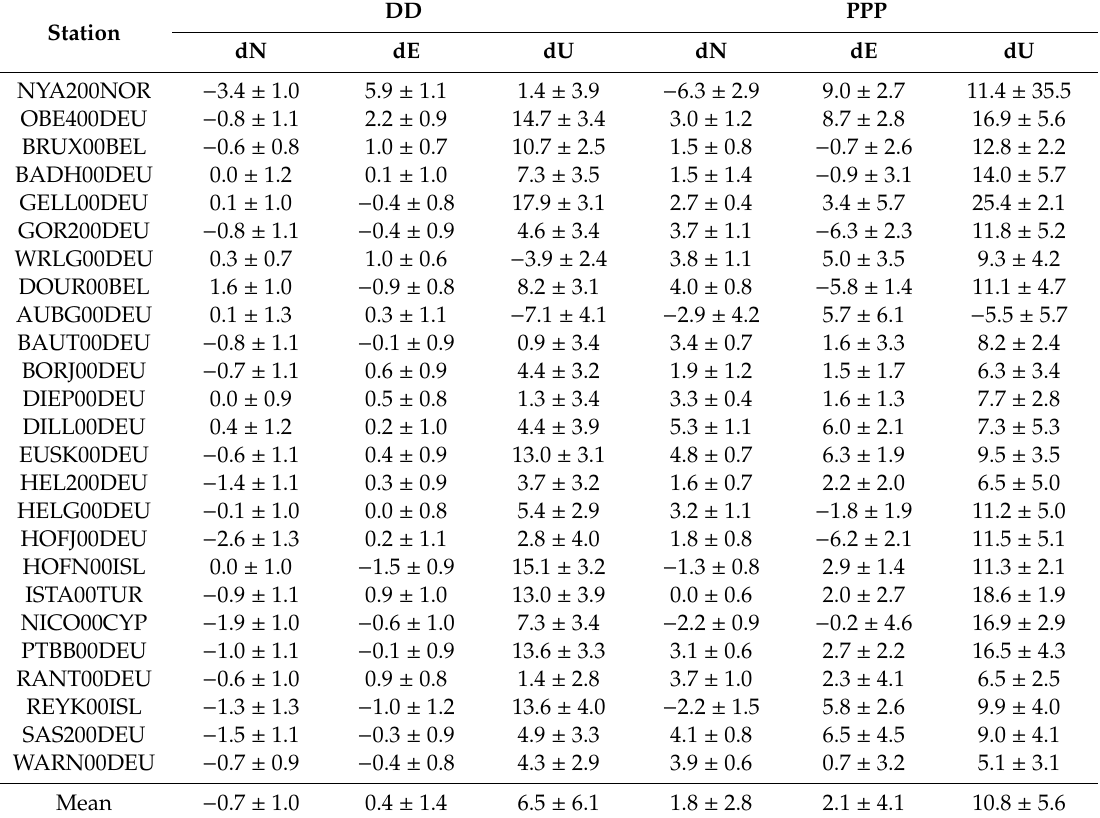
Table A3. Coordinate di ff erences between solution E1 and G1 (E1 minus G1) and their standard deviations. All values in millimeters.